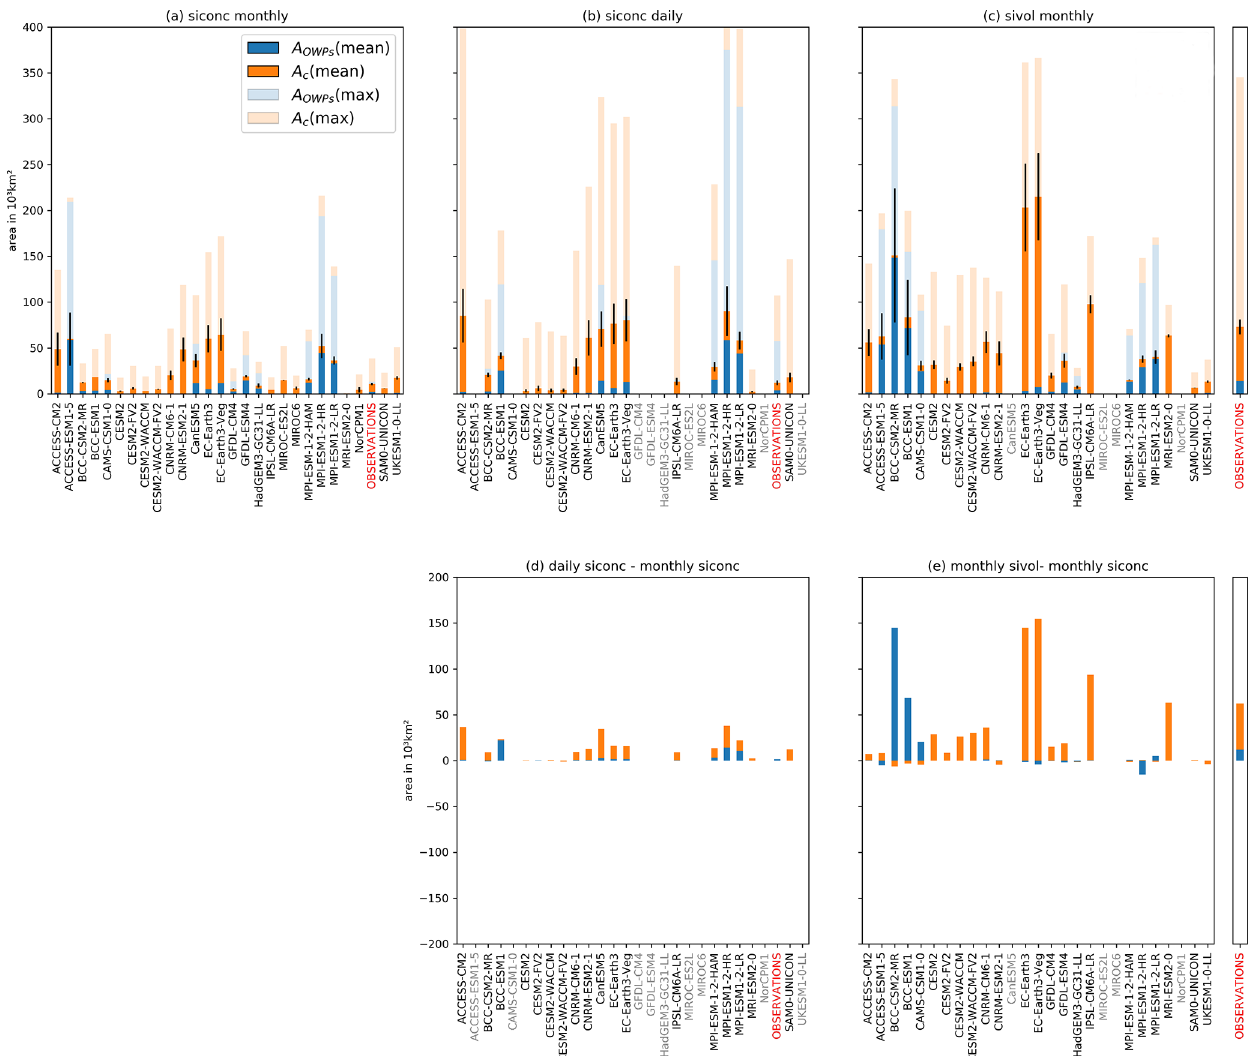
Figure 6. Winter polynya area for the CMIP6 models and the observational products (SMOS thin ice and OSI450). The polynyas are computed from (a) monthly sea ice concentration (b) daily sea ice concentration and (c) monthly sea ice thickness. The solid colours mark the yearly mean polynya area, while the transparent colours show the yearly maximum polynya area (Eqs. 1 and 2). The lower panels show the difference in yearly mean polynya area if derived from monthly/daily sea ice concentration (d) and monthly sea ice concentration/thickness (e) , for the subset of models that provided both outputs. All data sets were trimmed to the winter period according to Eqs. (1) and (2) respectively, and then the yearly mean from 1979 to and including 2014 for homogenisation in time was formed; the only exception is the observational sea ice thickness, which is not available before 2010 and is presented in a separate panel at its full length until November 2020 at the side of panels (c) and (e) . For the mean values in panels (a) , (b) and (c) , the black bars mark the range in which 50% of the results are